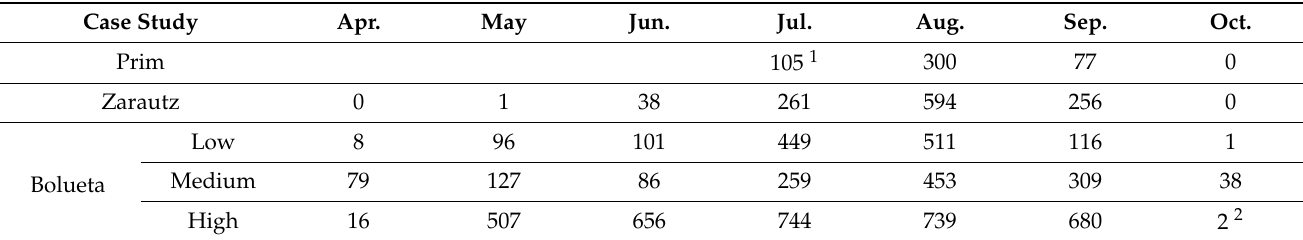
Table 8. Number of hours where T > 25 ◦ C, April–October